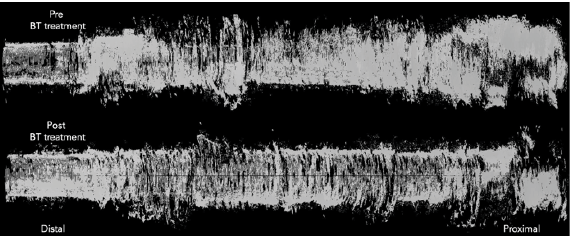
Fig. 4. 3D image of segmented ASM acquired during